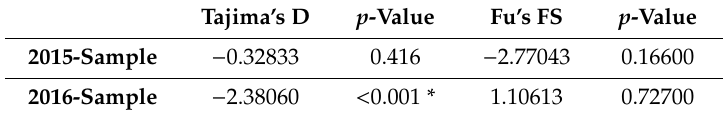
Table 5. Neutrality tests for mtDNA and their respective p -values (* indicates significant p -value). Tajima’s